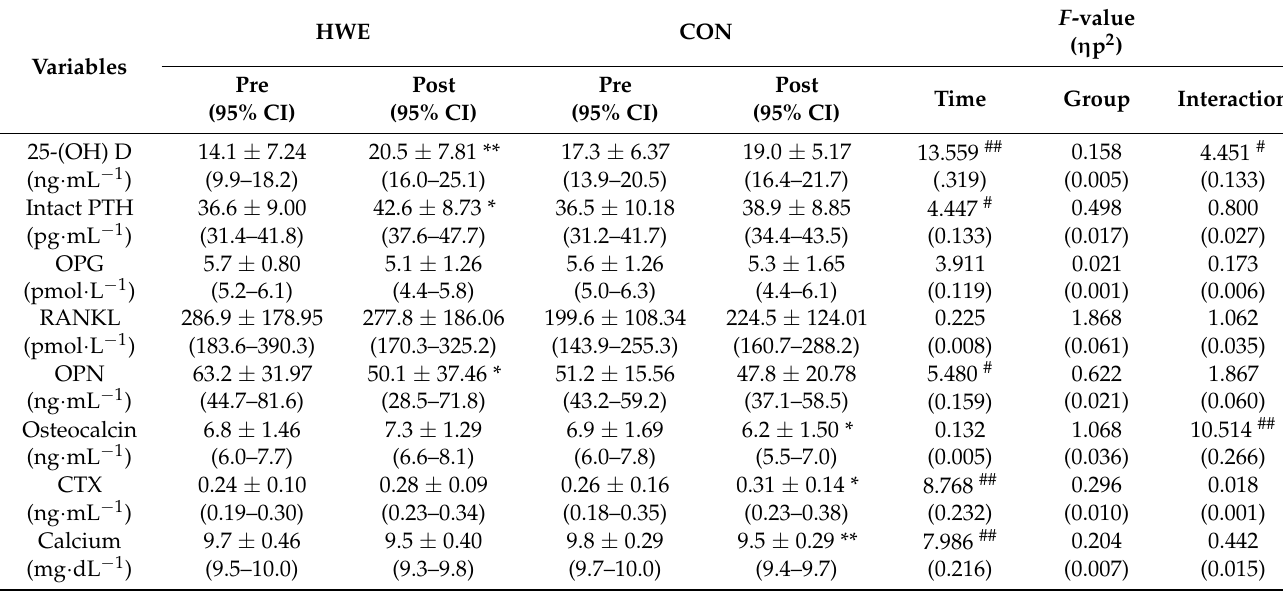
Table 4. Changes in bone metabolic markers between pre- and post-tests in middle-aged premenopausal women.